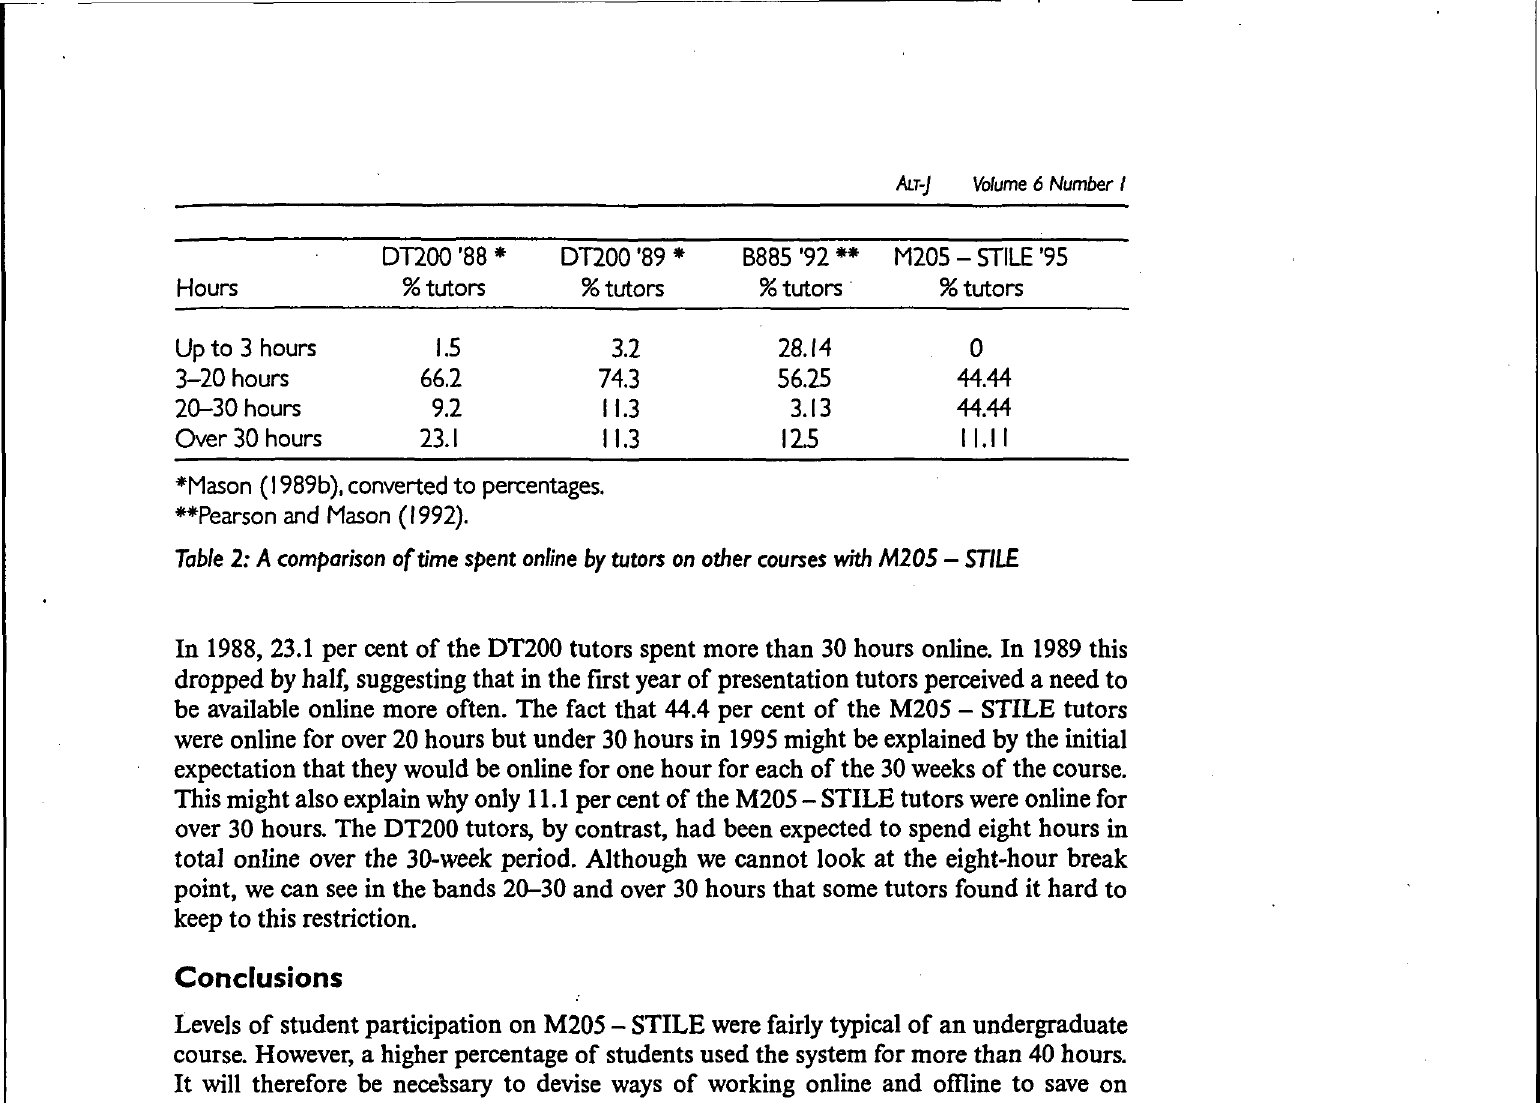
In 1988, 23.1 per cent of the DT200 tutors spent more than 30 hours online. In 1989 this dropped by half, suggesting that in the first year of presentation tutors perceived a need to be available online more often. The fact that 44.4 per cent of the M205 - STILE tutors were online for over 20 hours but under 30 hours in 1995 might be explained by the initial expectation that they would be online for one hour for each of the 30 weeks of the course. This might also explain why only 11.1 per cent of the M205 - STILE tutors were online for over 30 hours. The DT200 tutors, by contrast, had been expected to spend eight hours in total online over the 30-week period. Although we cannot look at the eight-hour break point, we can see in the bands 20-30 and over 30 hours that some tutors found it hard